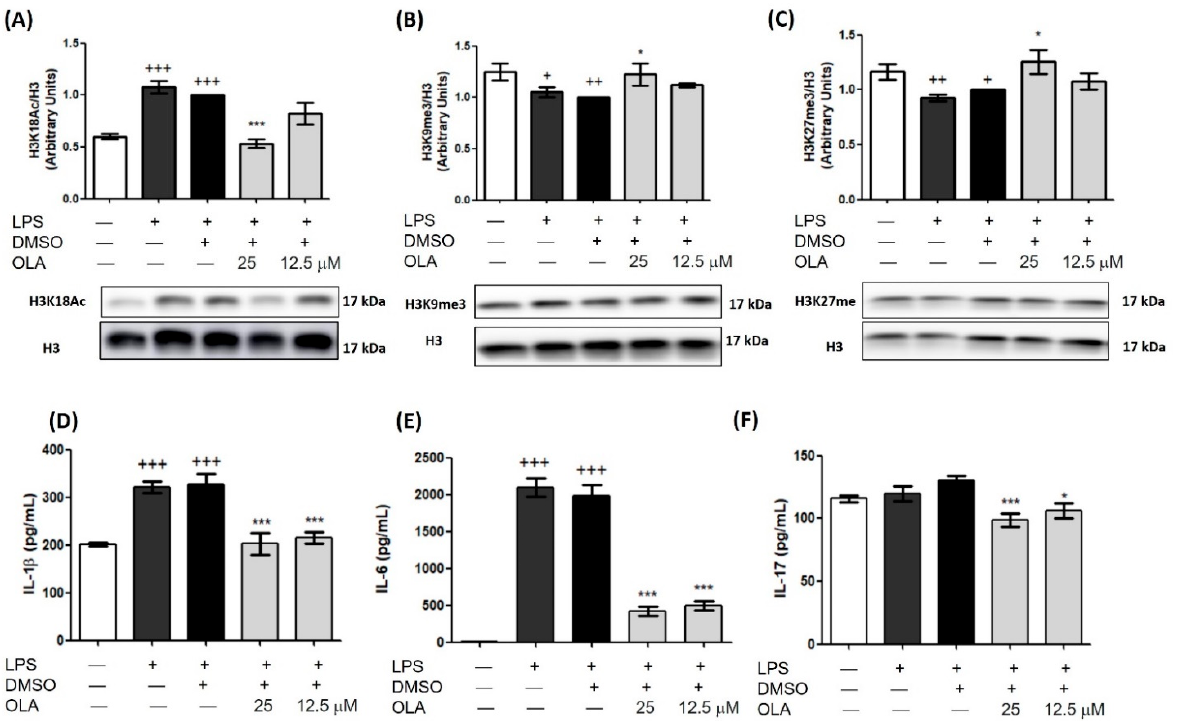
Figure 10. Modifications of histone acetylation ( A ) and methylation by OLA ( B , C ) and inhibition of the cytokine-related response ( D – F ). Spleen cells were treated with OLA (25 and 12.5 μ M) and stimulated with LPS for 24 h. Histones were isolated from cells with acid extraction and were evaluated by Western blot. Densitometry was performed following normalization to the control (H3 housekeeping gene). Cytokine levels were measured in cell supernatants using ELISA assays. Results are presented as mean ± SEM of ( n = 6). + p < 0.05, ++ p < 0.01, +++ p < 0.001 vs. control cells (no stimulated); * p < 0.05, *** p < 0.001 vs. LPS − DMSO-treated cells.